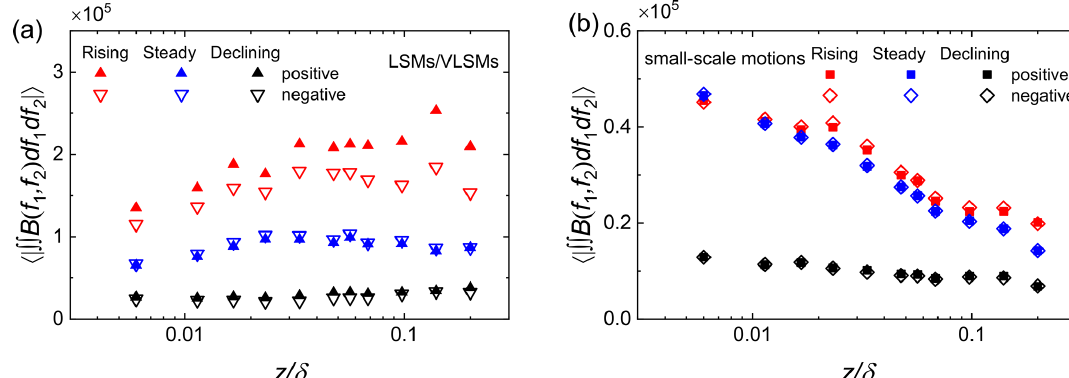
Figure 9. Variations in the average integral bispectra. (a) Results for the LSMs and VLSMs and (b) for the small-scale motions ( λ < 0 . 3 δ ). Red, blue, and black symbols represent the rising, steady, and declining stages, respectively; solid symbols denote the positive values of the average integral bispectra, and hollow symbols are the negative